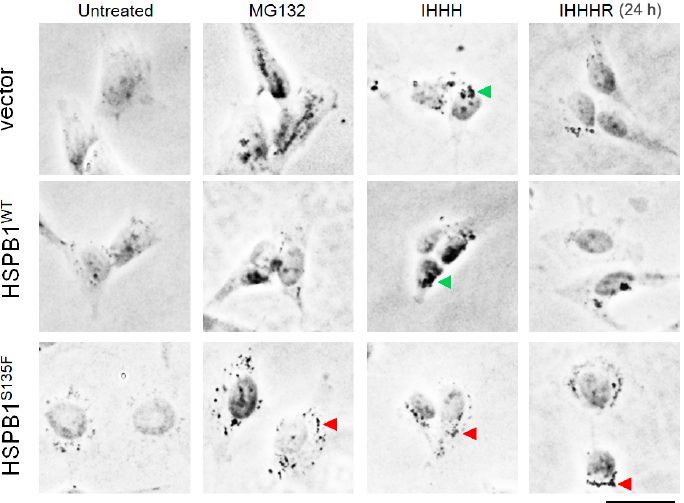
Figure 4. Aggresome formation in SH-SY5Y cells was probed by phase contrast microscope. Peri- nuclear aggresomes in cells with vector and HSPB1 WT are indicated by green arrowheads. Ag- gresomes were absent in HSPB1 S135F cells, no matter treated with MG132 or heat shock. Scatter black dots indicated by red arrowheads were not degraded in cells expressing HSPB1 S135F after recovery of 24 h. Scale bar: 50 µm.